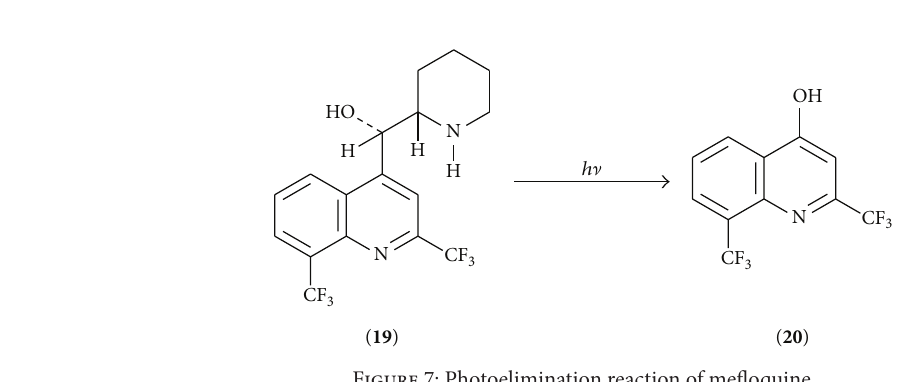
Figure 6: Photodimerization reaction of primaquine.